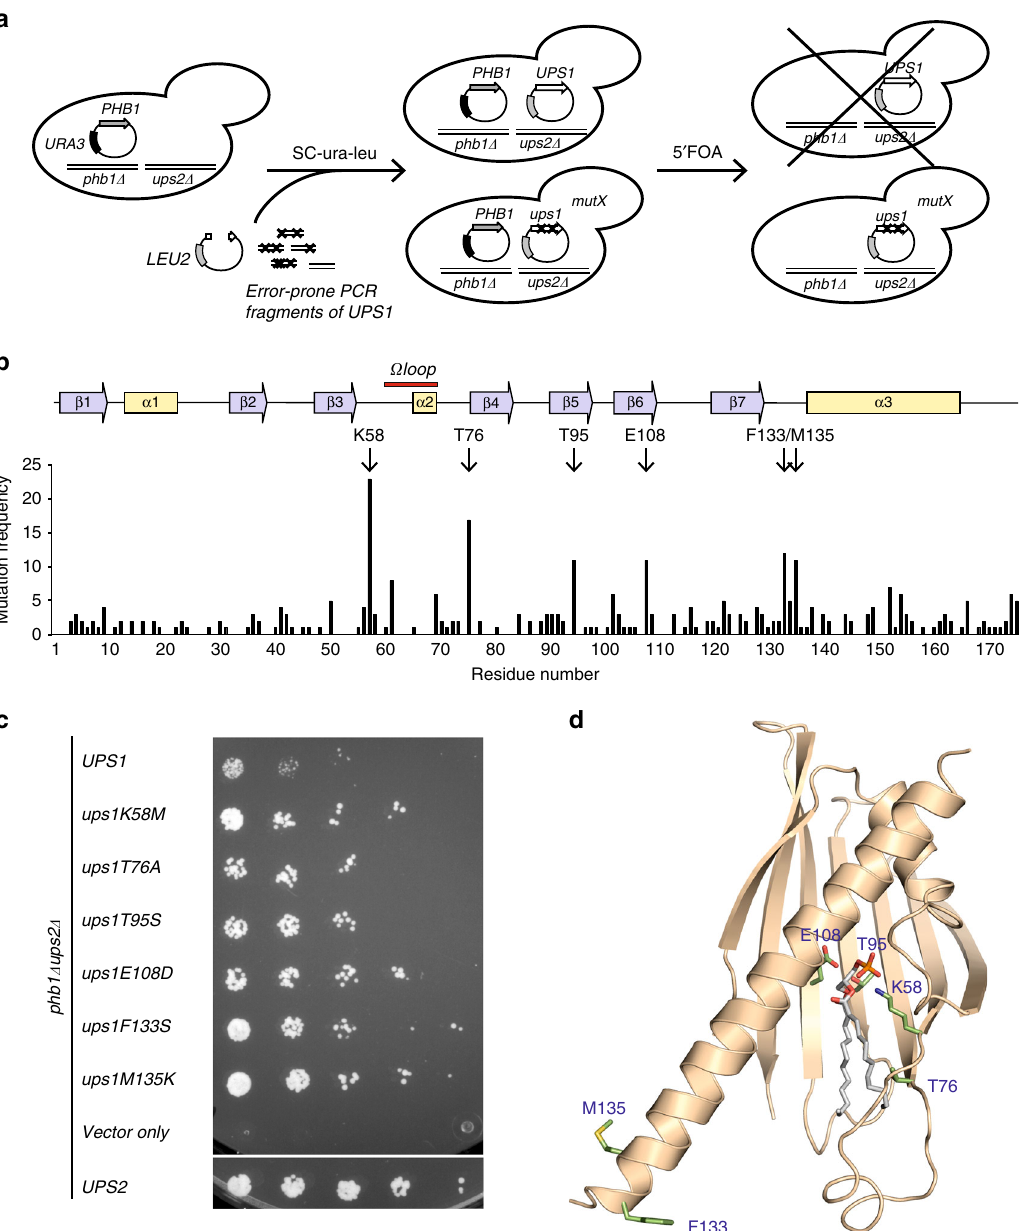
Fig. 2 Identi fi cation of Ups1 variants transferring PS. a Reverse genetic screen for Ups1 variants substituting for Ups2. ups2 Δ phb1 Δ cells harbouring plasmid- borne PHB1 and URA3 were transformed with a linearised yeast plasmid and with PCR fragments of the UPS1 gene that were ampli fi ed by error-prone PCR. The plasmid encoding URA3 was excluded from cells upon growth of the transformants in the presence of 5- fl uorouracil-6-carboxylic acid (5 ′ FOA). Plasmids encoding Ups1 mutants were isolated from growing cells and sequenced. b The frequency of mutations in Ups1 variants. Amino acids that were found mutated in >10 Ups1 variants are highlighted. Secondary structure elements in Ups1 are shown. c Growth of ups2 Δ phb1 Δ cells expressing myc-tagged Ups2, Ups1 or the indicated Ups1 variants on selective medium containing glucose and 5 ′ FOA. d Crystal structure of PA-bound Ups1 20 ([pdb:4ytx]) with amino acids highlighted that were found to be most frequently